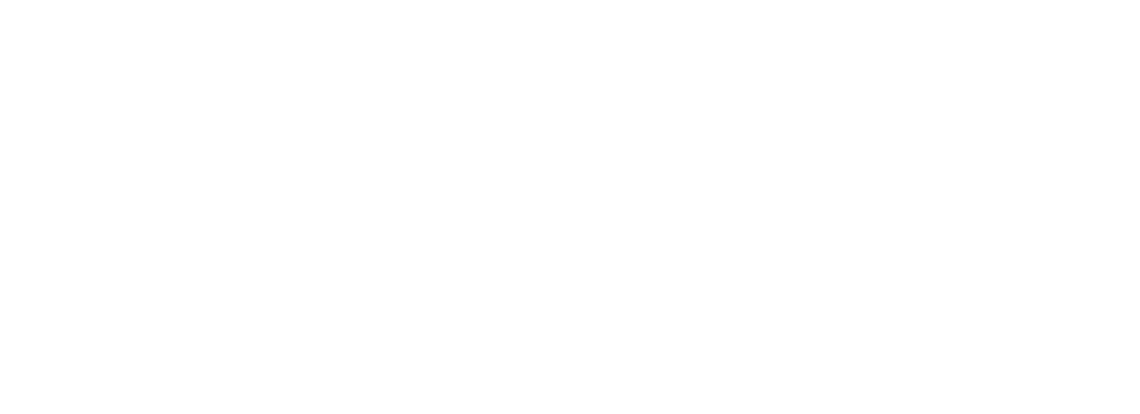
Frontiers in Pharmacology | Experimental Pharmacology and Drug